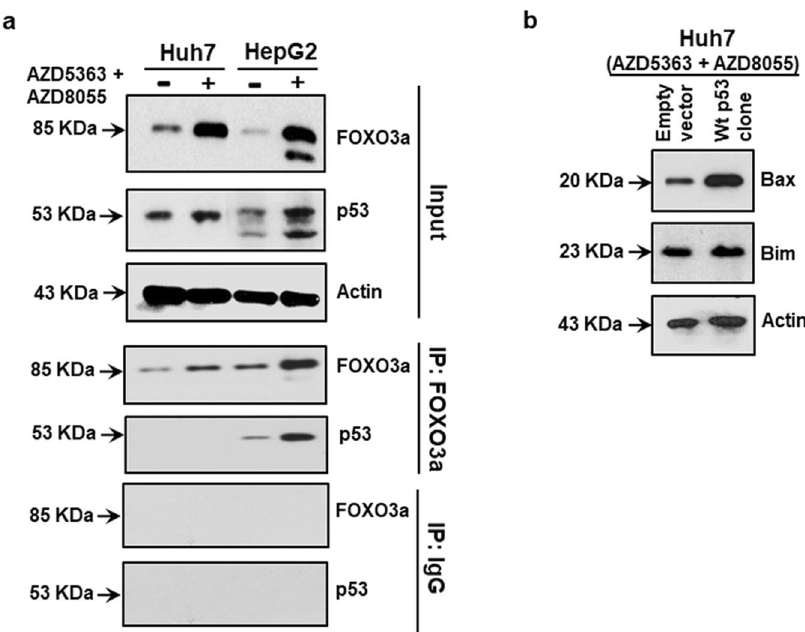
Fig. 6 p53 mediated FOXO3a regulation and Bax/Bim expression. Immunoprecipitation experiment was performed in Huh7 (p53 defective) and HepG2 (wild-type p53) cells to examine the direct interaction between functional FOXO3a and p53 in the presence or absence